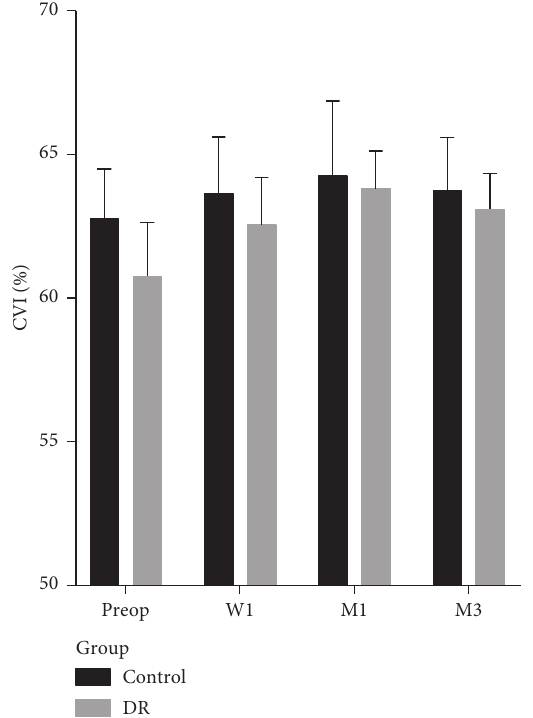
Figure 2: The choroidal vascularity index for patients with mild/ moderate NPDR (DR) and nondiabetic patients (control) at the four visits (mean ± SEM). W1:1 wk postop; M1:1 mo postop; M3: 3 mo